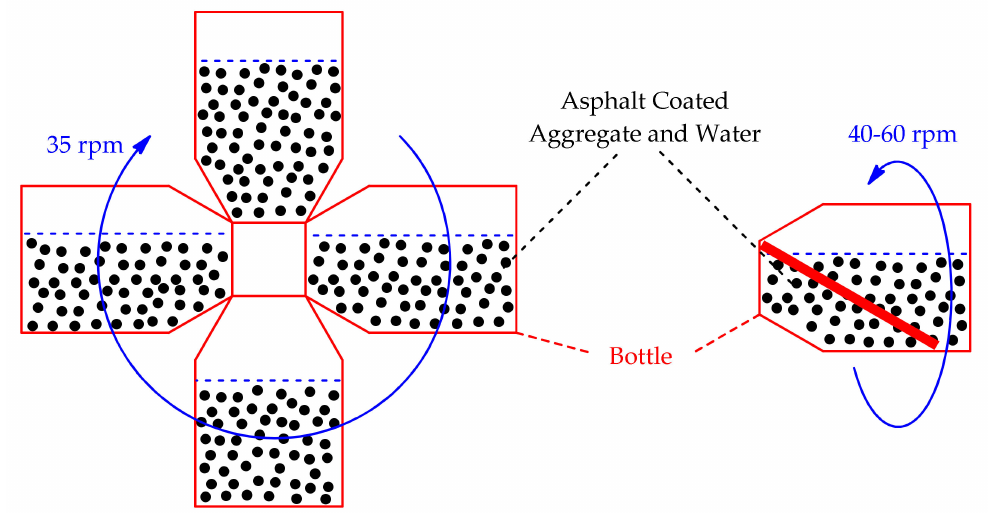
Figure 7. Rotating bitumen/aggregate mixture in a sealed bottle for film stripping test and rolling bottle